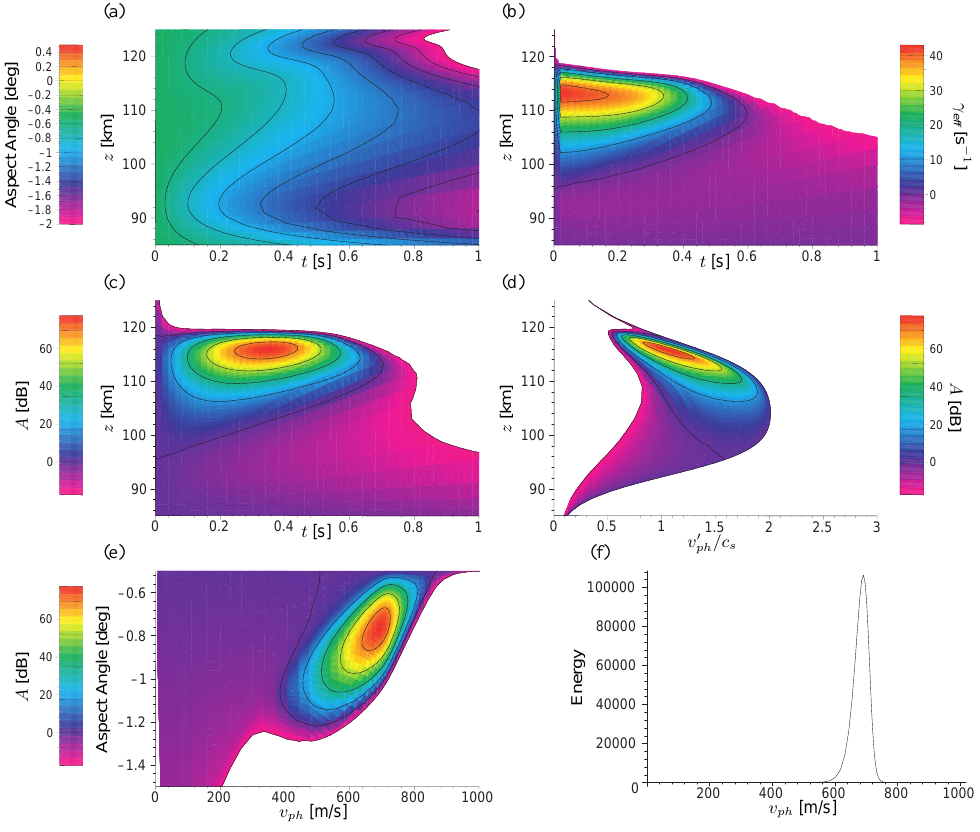
Fig. 9. Same case as in Fig. 5 but for an initial condition associated with a uniform aspect angle of − 0 . 5 ◦ . Panels (a) , (b) and (c) are the same as panels (a), (e) and (f) in Fig. 5, respectively. Panels (d) , (e) and (f) are the same as panels (b), (d) and (e) in Fig.